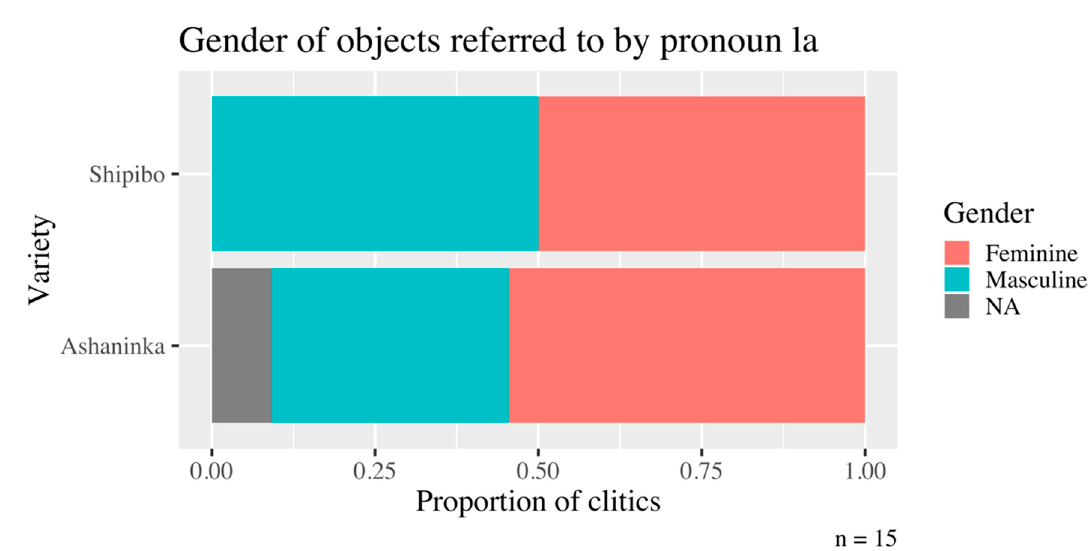
Figure 12. Gender of objects referred to by pronoun la.